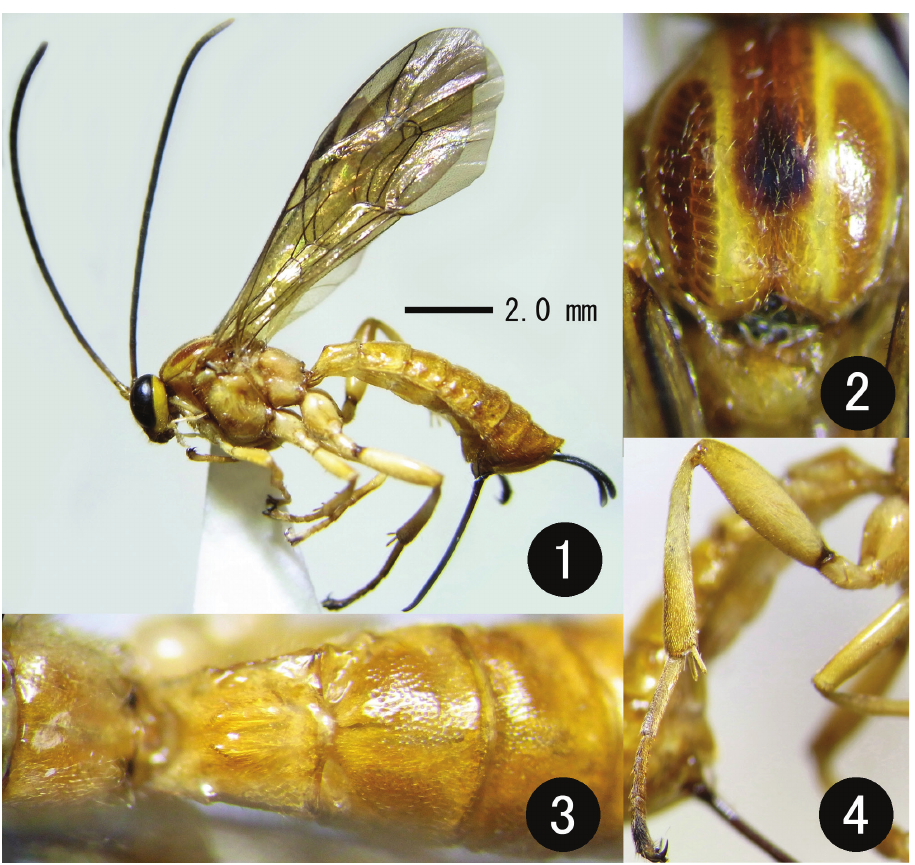
Figures 1–4. Holotype of A . cantika sp. n. 1 habitus, lateral view 2 mesonotum, dorsal view 3 T1-T2, dorsal view 4 right hind leg, lateral